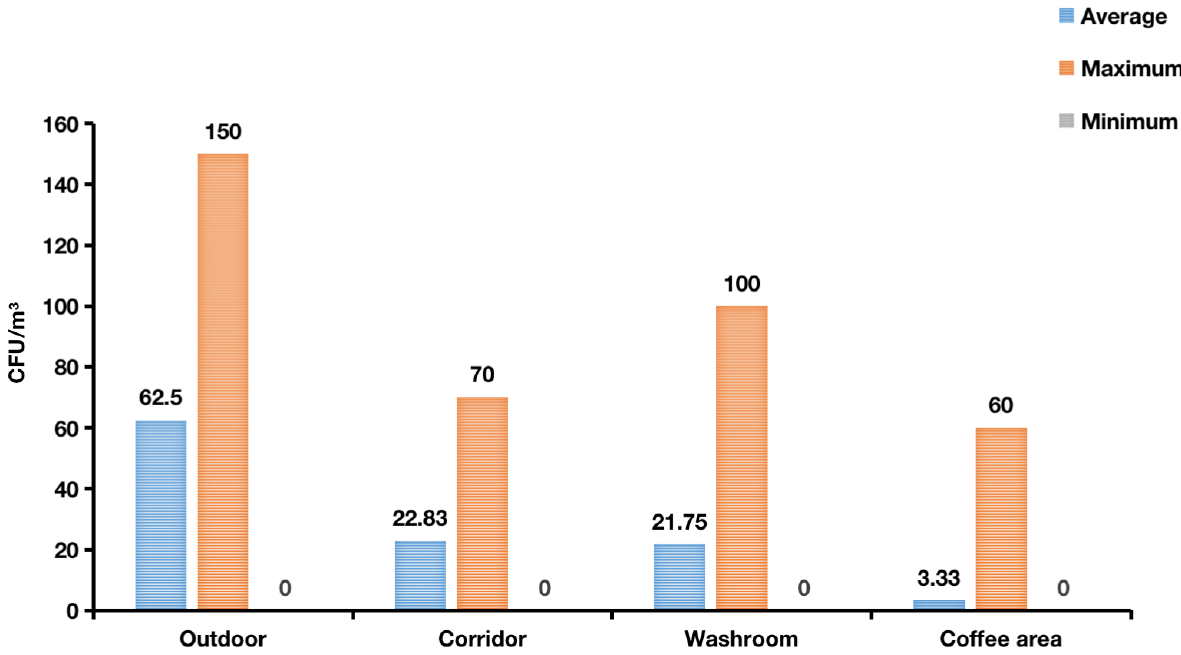
Figure 4. Distribution of fungal strains in different sampling locations.